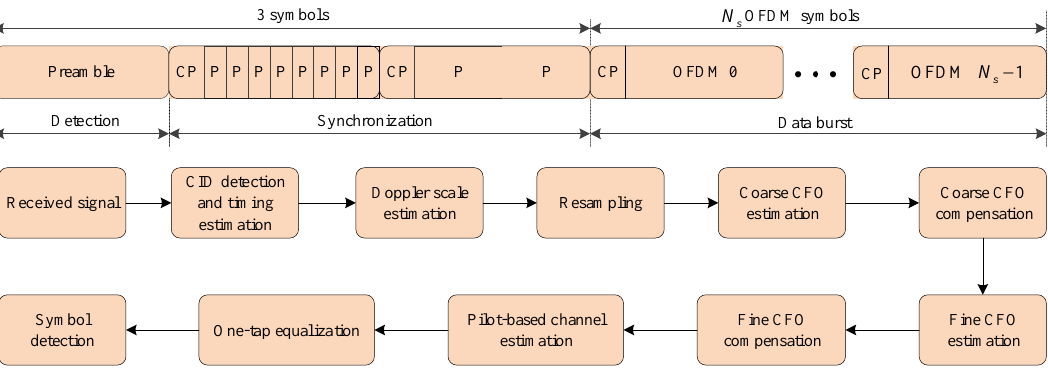
Figure 1. Downlink frame structure and receiver